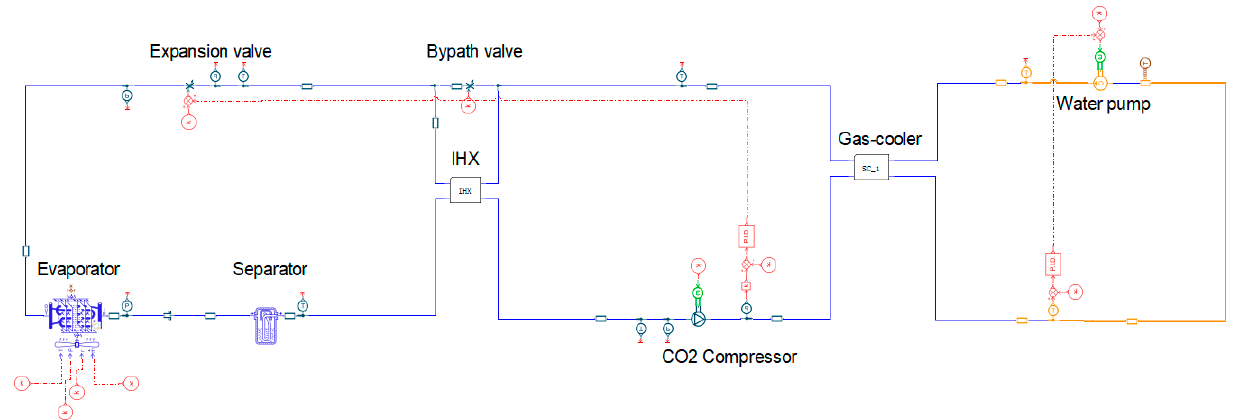
Figure 2. The AMESim model of the transcritical CO 2 heat pump system.